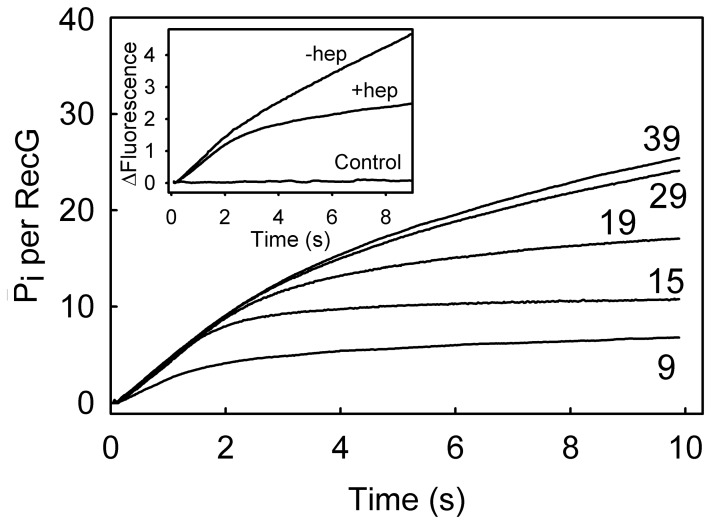
ATP hydrolysis during unwinding 4-strand complementary junctions.Junctions of varying arm lengths (shown in b.p.) were used to measure the rate of ATP hydrolysis during unwinding. RecG was pre-incubated with junction and the reactions were initiated by rapid mixing with ATP and heparin. Final concentrations are 200 nM DNA junction (A∶B′∶C∶D), 10 nM RecG, 200 µM ATP, 1 mg ml−1 (55.5 µM) heparin and 5 µM MDCC-PBP. The reactions were performed in the presence of a Pi mop, described in materials and methods. Inset: Effect of heparin on ATPase activity of RecG during unwinding. The reactions were initiated by rapidly mixing the pre-incubated RecG.DNA (A40:B′40:C19) with ATP with or without heparin. In another measurement (“control”), RecG was pre-incubated with heparin and then rapidly mixed with DNA junction (A40:B′40:C19) plus ATP. Final concentrations are 200 nM DNA junction, 10 nM RecG, 200 µM ATP, 2 mg ml−1 (111 µM) heparin and 5 µM MDCC-PBP with Pi mop.